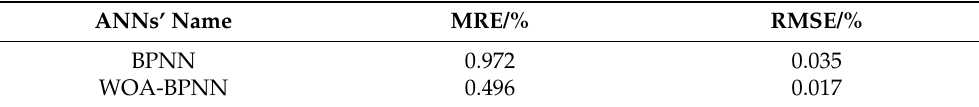
Table 2. Comparison of prediction errors between BPNN and